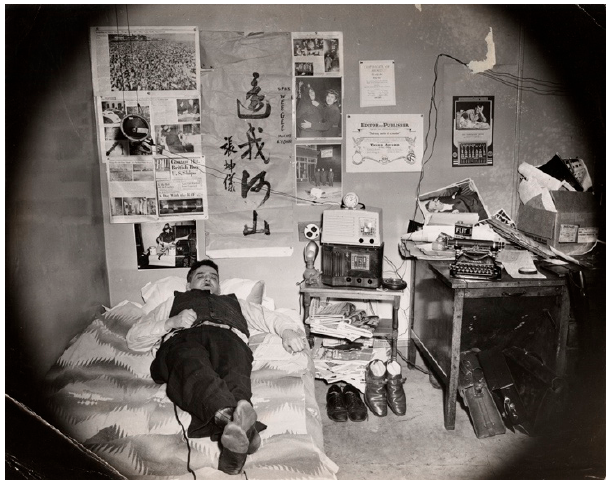
Figure 7. Weegee, [Weegee lying on bed in his studio, New York], 1941. © Weegee/International Center of Photography (2215.1993).